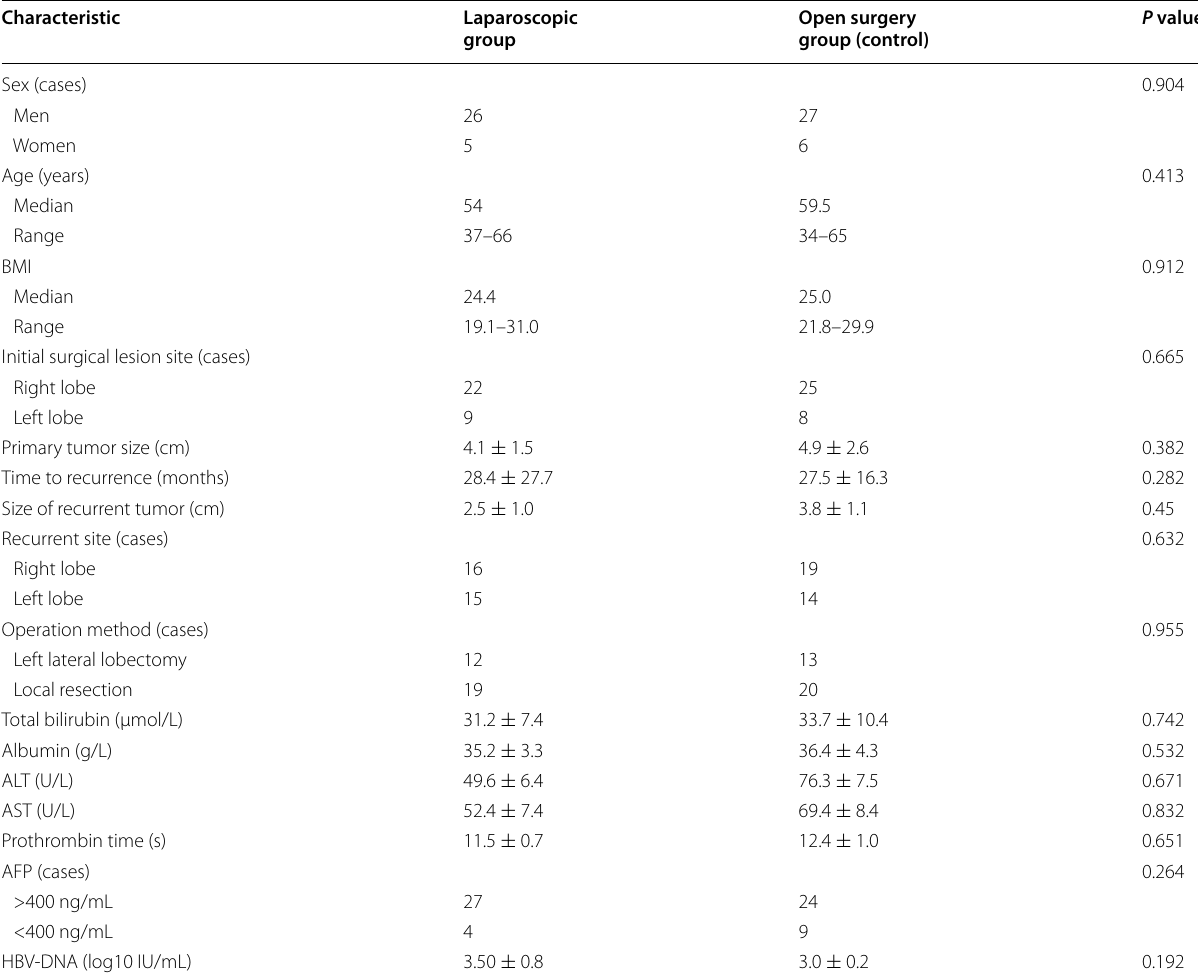
Table 1 Baseline characteristics of all enrolled patients